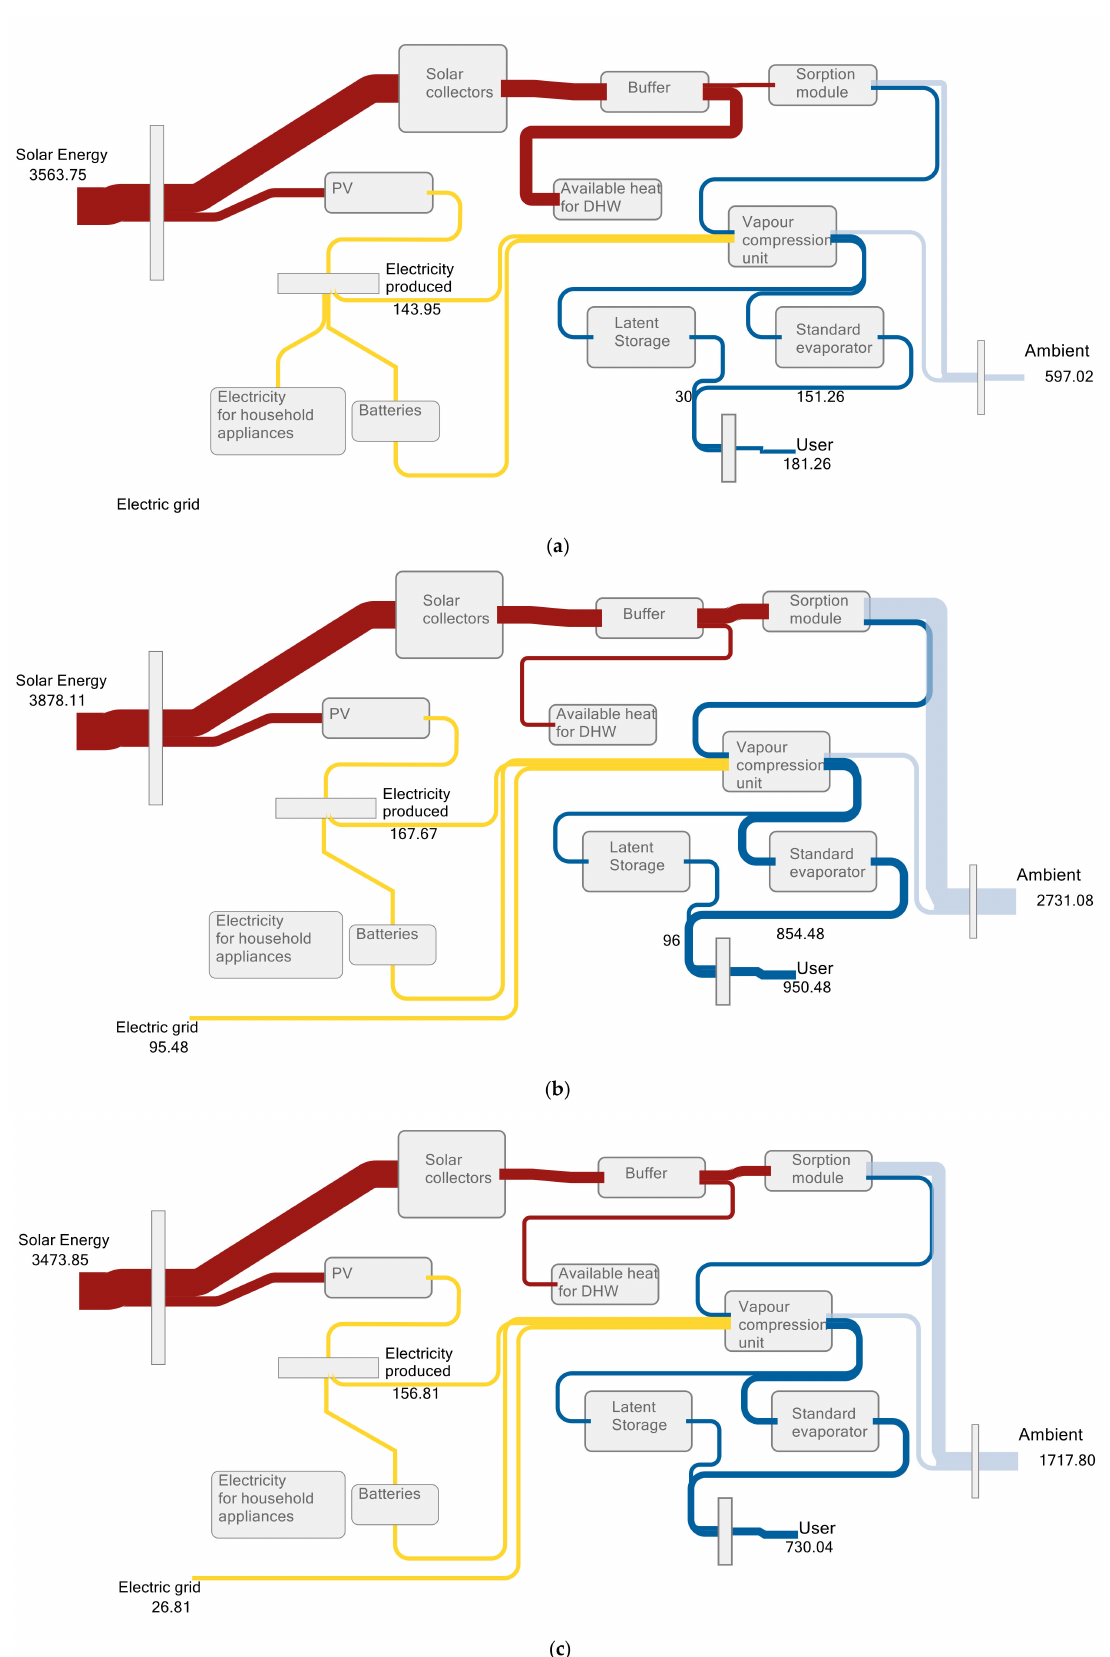
Figure 18. Sankey diagrams for three reference weeks in the climate of Athens: ( a ) 7–14 June, ( b ) 21–28 June, ( c ) 28 August– 4 September. All the flows are in